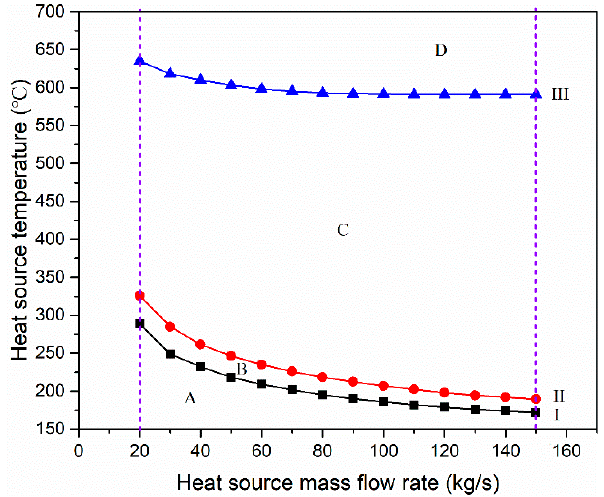
Figure 17. Selection map of the ORC system vs. SRC system based on EPC 0 = 0.057 $/kWh.